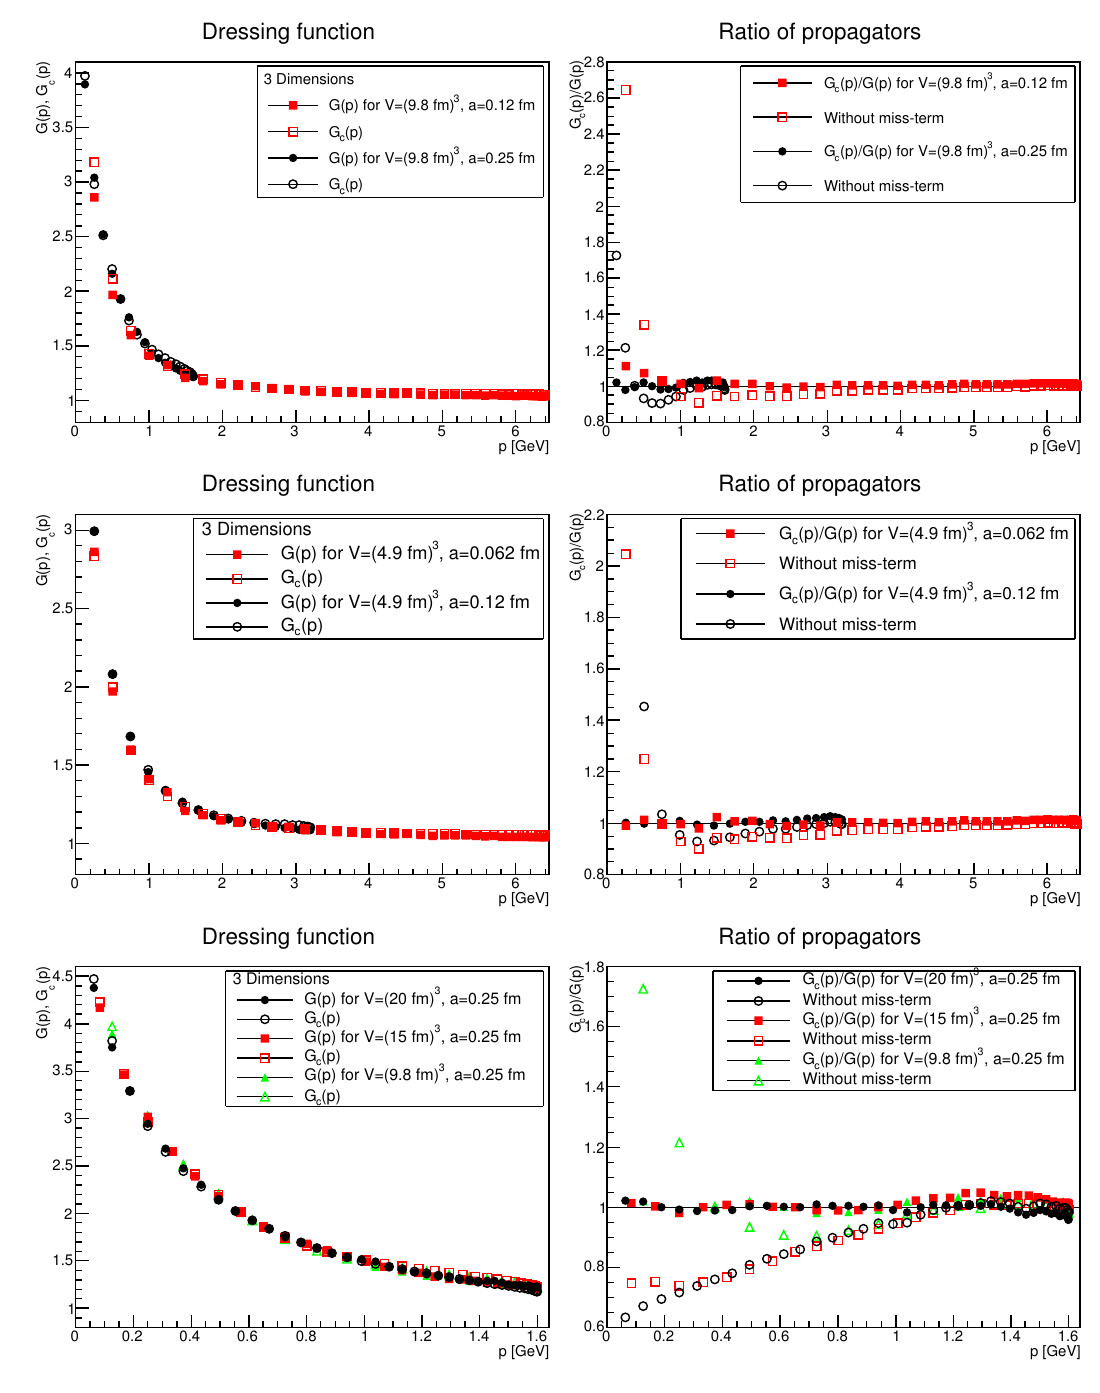
Figure 2: Same as figure 1, but in three dimensions. In addition, the top and mid- dle panels show results for different discretizations at fixed physical volume for two